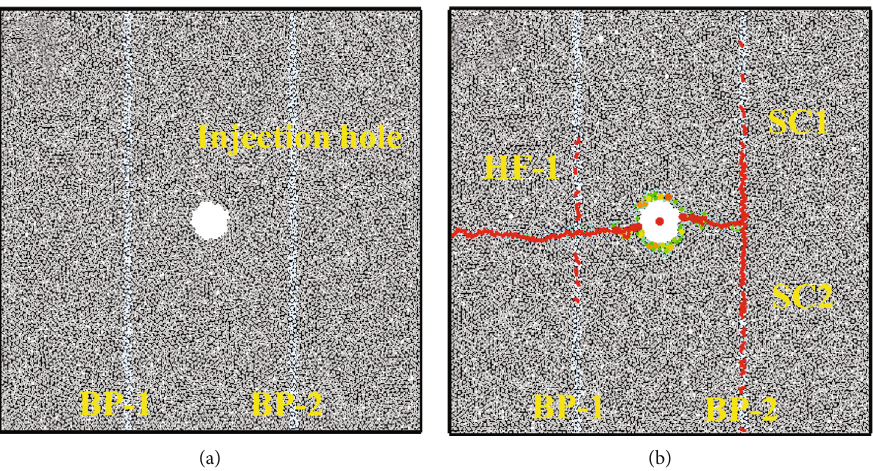
Figure 8: Group 1-2 hydraulic fracture test: (a) test block before hydraulic fracturing; (b) test block after hydraulic